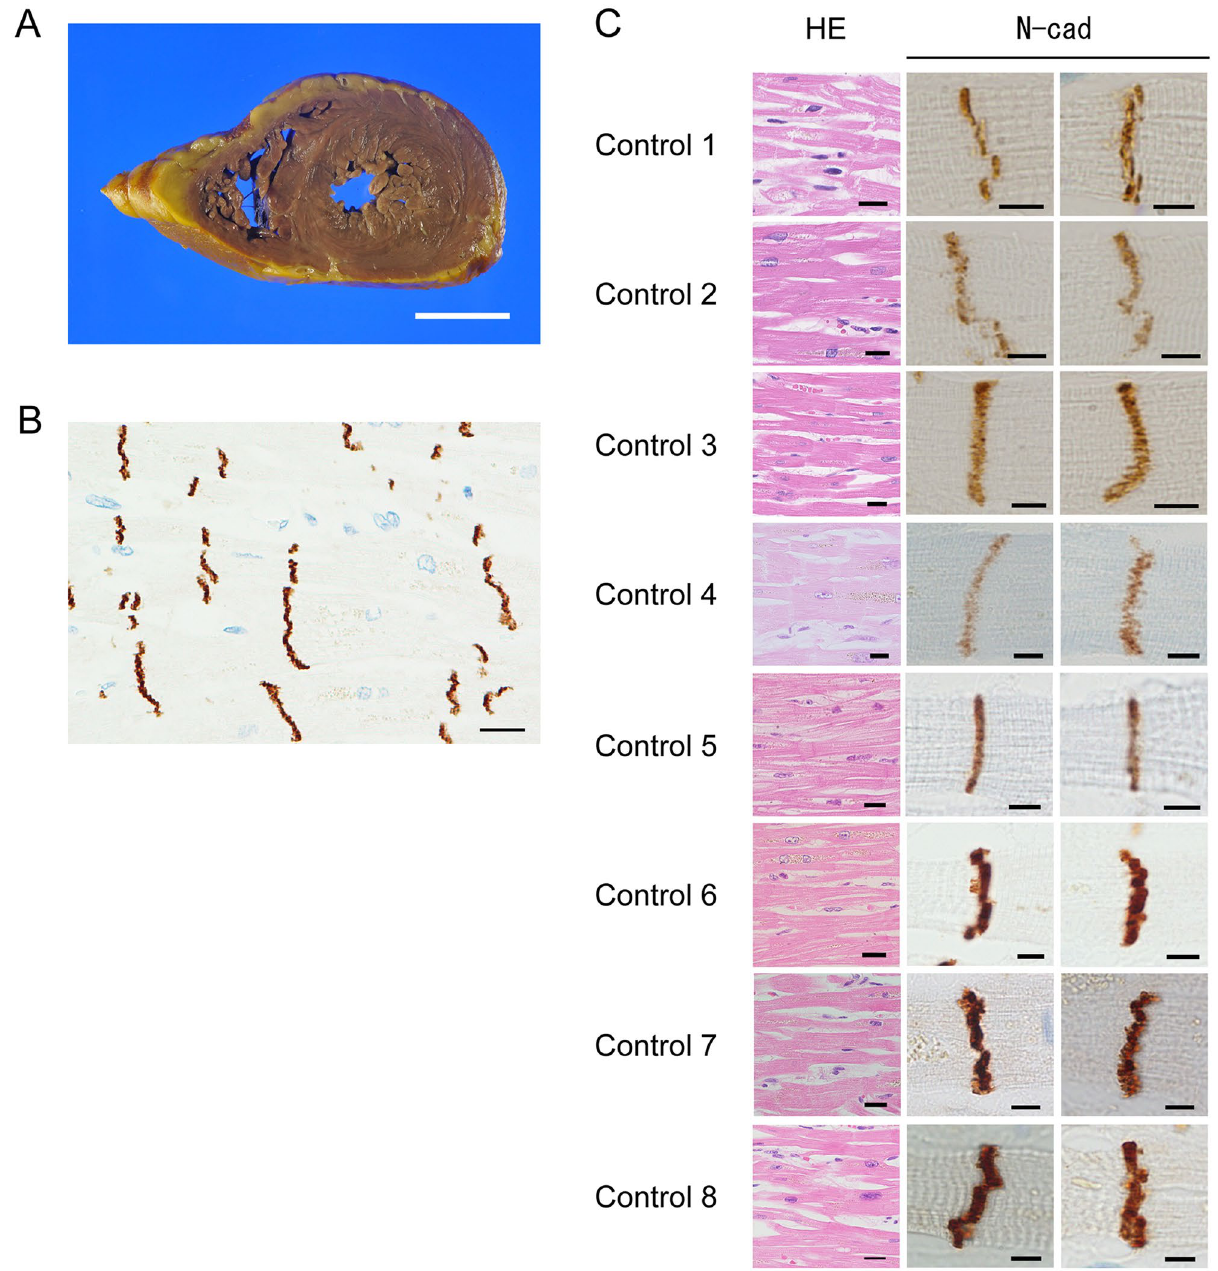
Figure 2. Pathological and immunohistochemical findings in control cases. ( A ) Macroscopically, we observed no dilation of the bilateral ventricles. The LV wall had a uniform thickness. ( B ) ICDs could be clearly observed, and cardiomyocyte units were clear. (N-cadherin immunostaining; scale bar, 20 µm; original magnification, × 400). ( C ) Histologically, ICDs were observed between cardiomyocytes ( H – E staining; scale bar, 20 µm; original magnification, × 400). Each cardiomyocyte could be clearly distinguished. Immunohistochemistry for N-cadherin revealed positive staining at ICDs, and ICDs were thin and flat. (N-cadherin immunostaining; scale bar, 5 µm; original magnification, × 1000). ICD width was within two DCM versus CHF. ICD width was greater in the DCM group than in the CHF group (Fig. 4A, B). Some of the sarcomeres had disappeared, and the remaining ones were arranged in a complex manner. In the CHF group, the ICD ultrastructure was preserved in the CHF group, and interdigitation of ICDs was also retained. CHF versus control. In the CHF group, ICDs were bit wider than in the control group, spanning about two sarcomeres (Fig. 4C). However, the ICD ultrastructure was preserved in both groups, and interdigitation of ICDs was also retained.